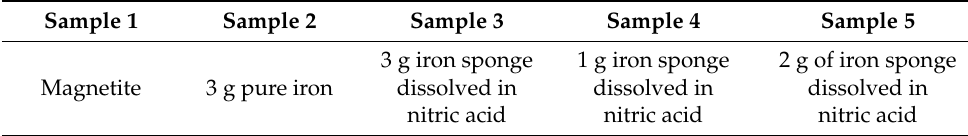
Table 4. Iron and magnetite added into carbon form for each